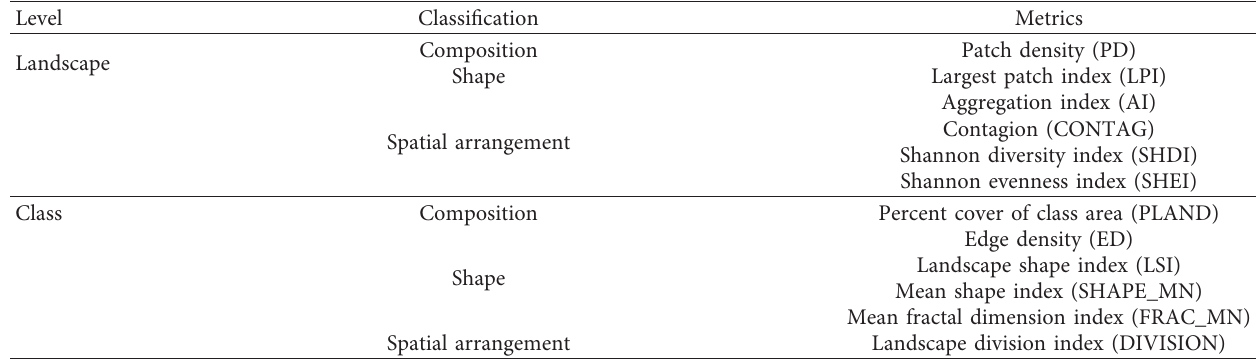
Table 2: List of landscape metrics [62, 66].